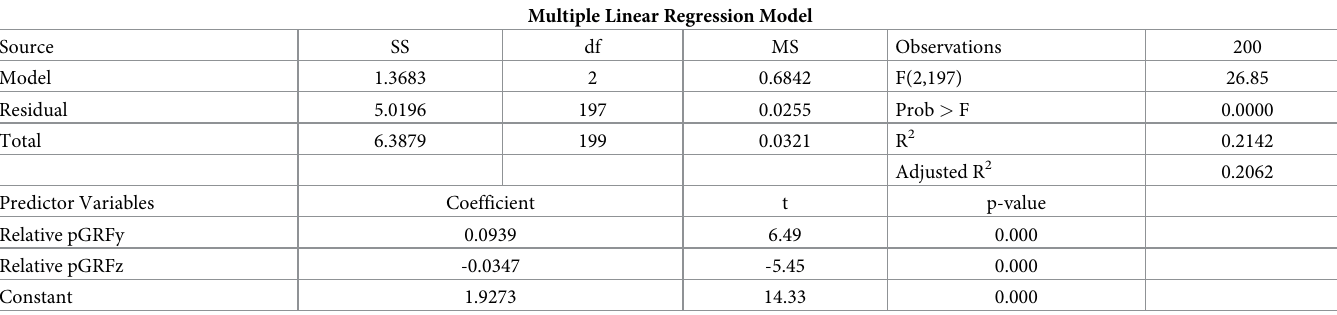
Table 4. Multiple linear regression model predicting lateral jump distance; derived with full trial set, relative